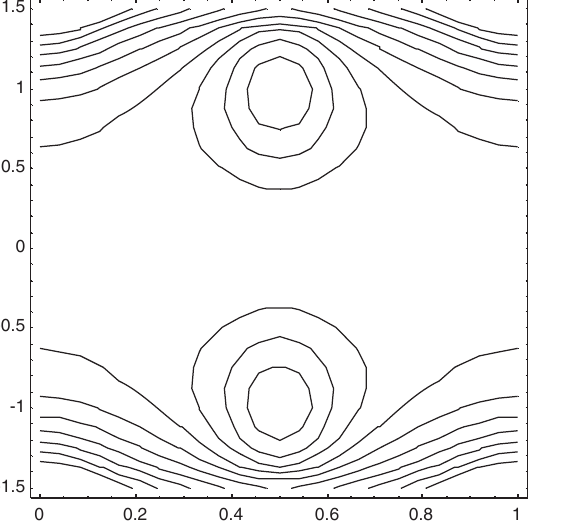
parameters remaining unaltered [cf. Figs. 17–19]. Ali